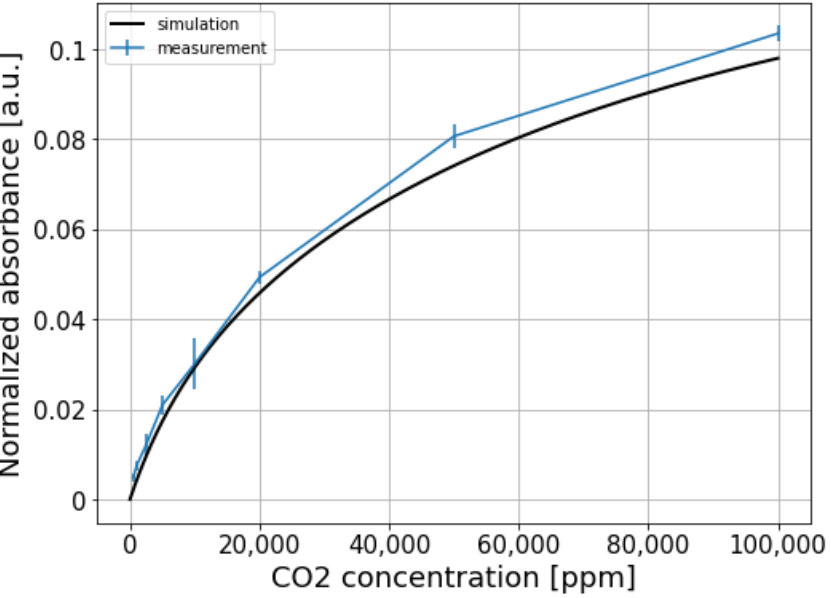
Figure 9. Normalized absorbance of the fully integrated sensor at different CO 2